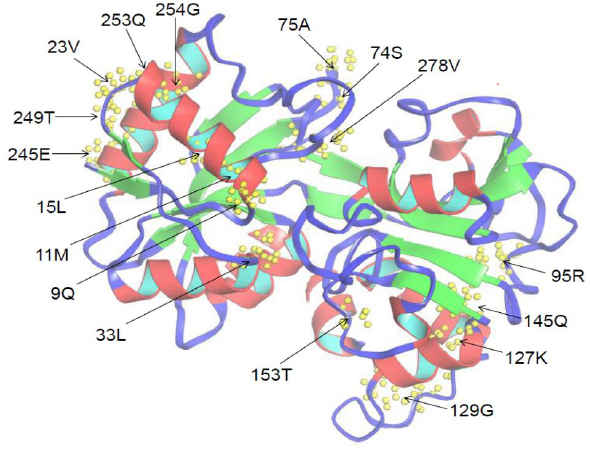
Figure 5. Three-dimensional structure of the N-lobe of TF protein in Amur stickleback predicted with the I-TASSER server [55]. Seventeen positive selection sites predicted by M8 model are marked with arrows. Table 4. Likelihood values and parameter estimates for N-lobe and C-lobe of TF genes. Ka/Ks : the synonymous rate ( Ks ) and non-synonymous rate ( Ka ) of nucleotide substitution; ω s: beta + w.